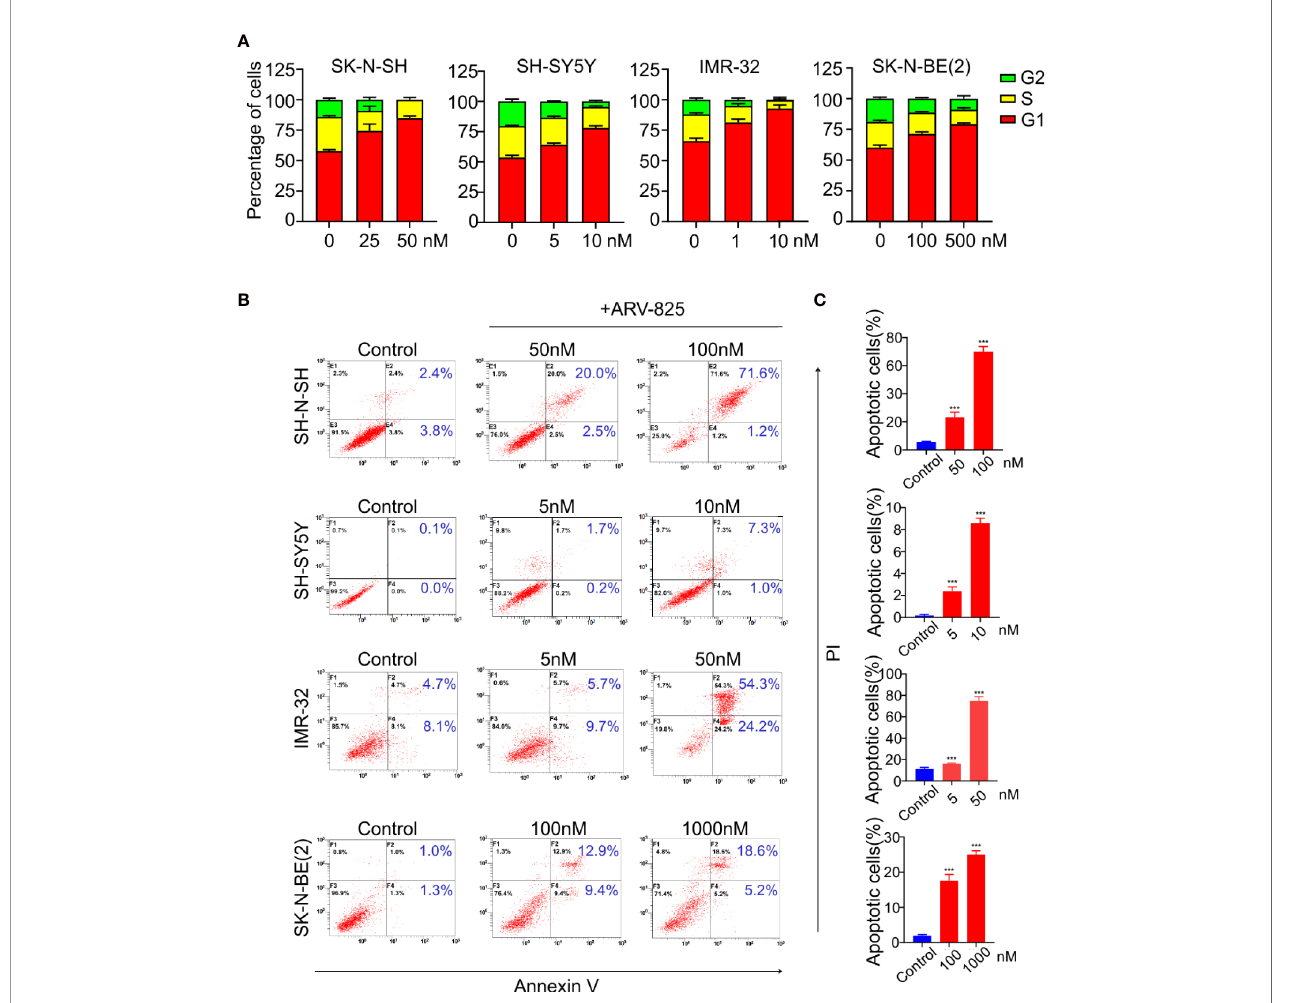
FIGURE 5 | ARV-825 elicits cell cycle arrest and apoptosis in NB cells. (A) Cell cycle analysis showed ARV-825 induced an increased proportion of the G1 phase and concurrently decreased S and G2 proportion in NB cells. (B) Annexin V/PI staining showed an increased proportion of apoptotic cells in NB cells after treated with ARV-825 at indicated concentrations. (C) The proportion of apoptotic cells increased signi fi cantly in NB cells treated by ARV-825. *** p <